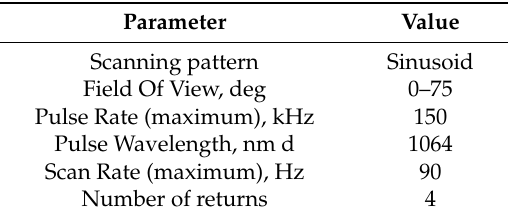
Table 1. Leica Geosystems ALS-50 II CM